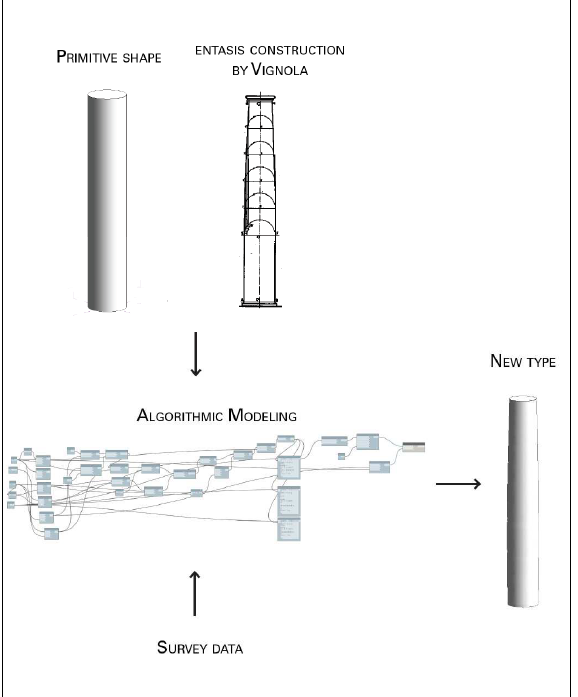
Figure 6. Development of entasis algorithm